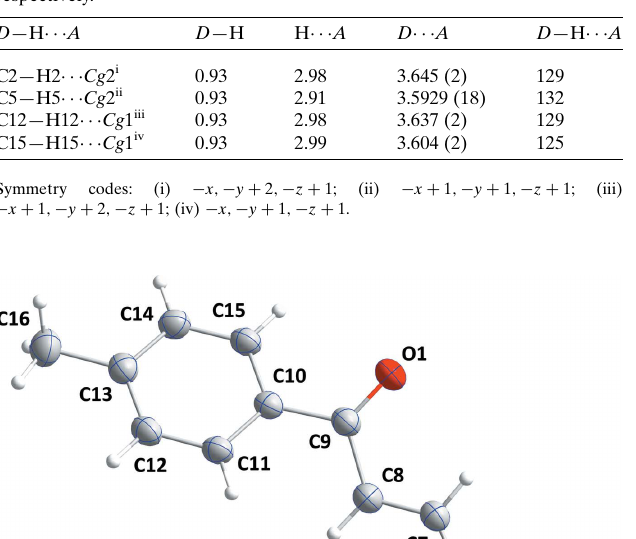
Table 2 Experimental details.